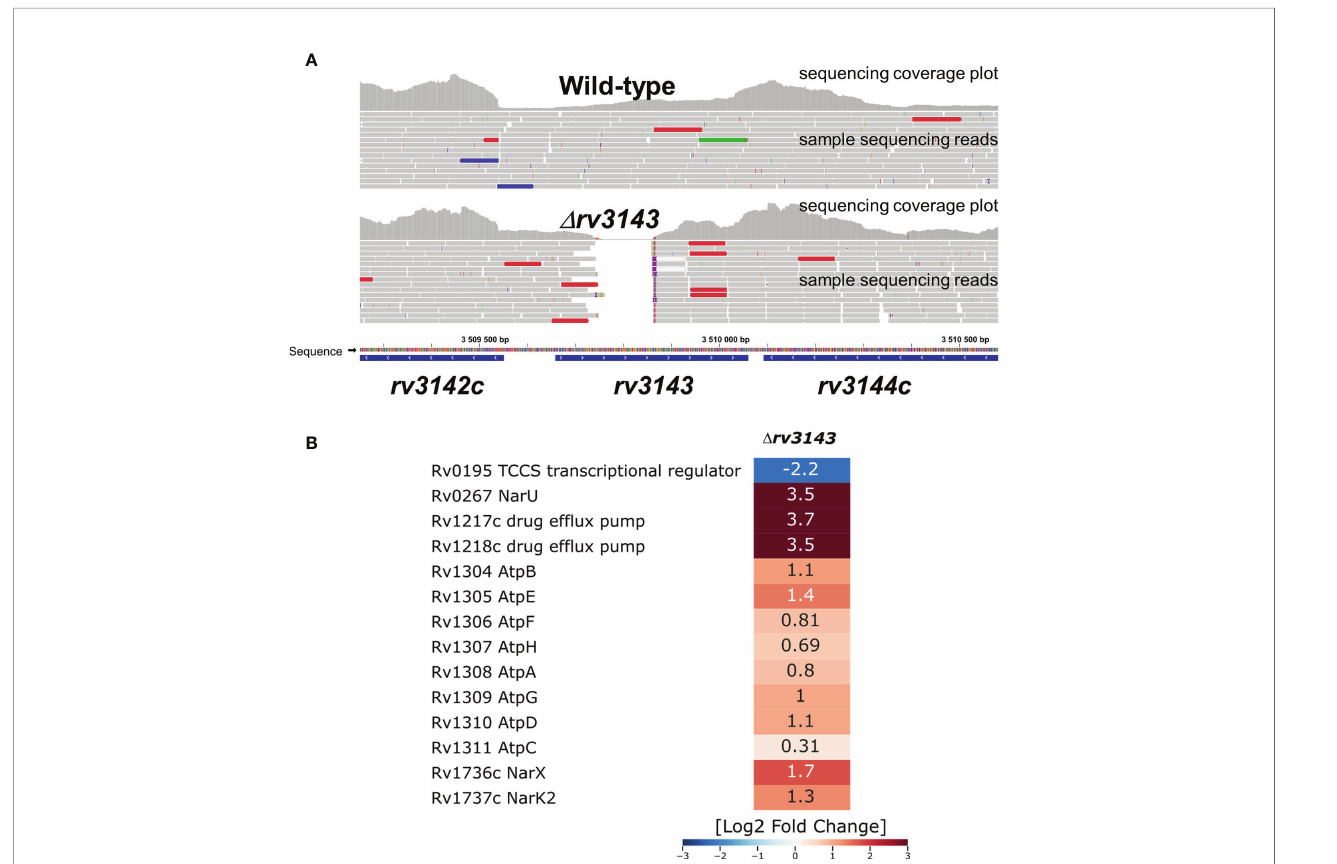
FIGURE 3 | Selected transcriptional changes observed in the D rv3143 mutant strain grown under standard laboratory conditions compared to the wild-type H37Rv Mycobacterium tuberculosis strain. (A) Con fi rmation of rv3143 deletion from sequencing reads, image modi fi ed from Integrative Genomics Viewer v2.8.13. Regular paired-end sequencing reads are represented as gray bars. Colored reads either contain insertions (red) and deletions (blue) or have an opposite read pair orientation (green). (B) Log2-fold change values are shown in a heatmap generated in Seaborn software based on total RNA sequencing and differential expression estimation from the Degust online RNA-Seq analysis